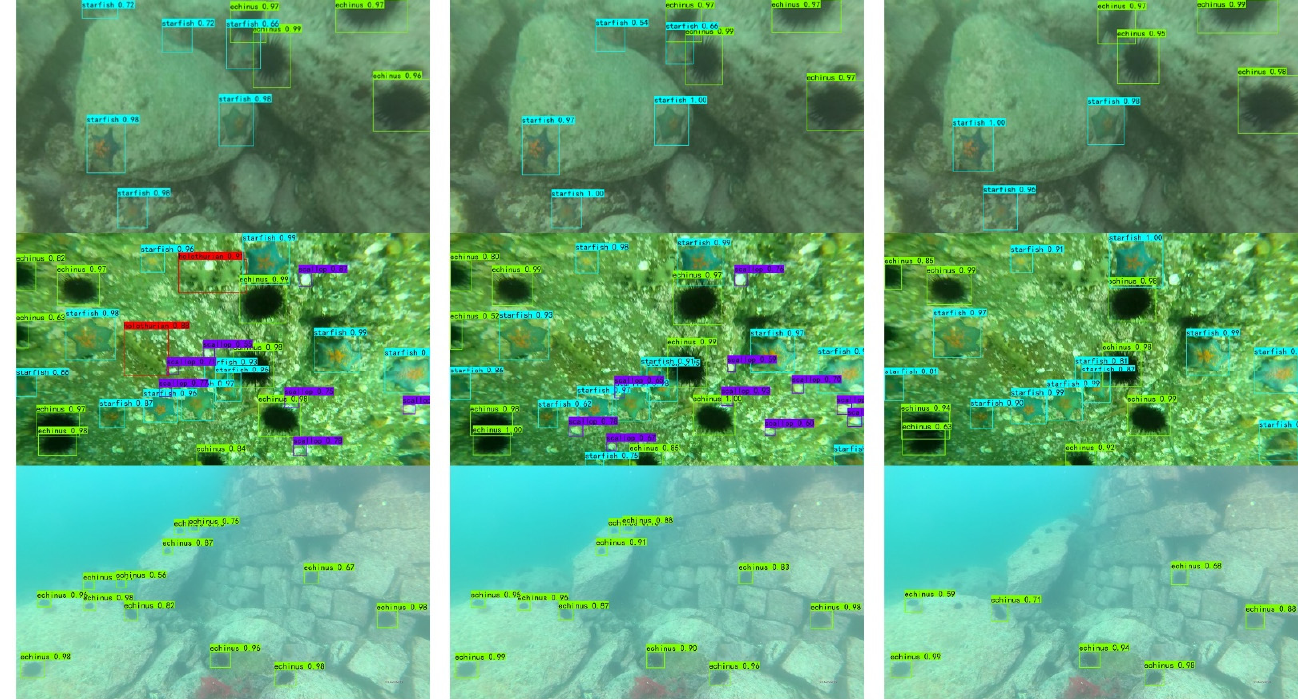
v4. Figure 11. Visualization detection results for the URPC 2020 underwater dataset compared with YOLO v4 and Tiny YOLO v4.